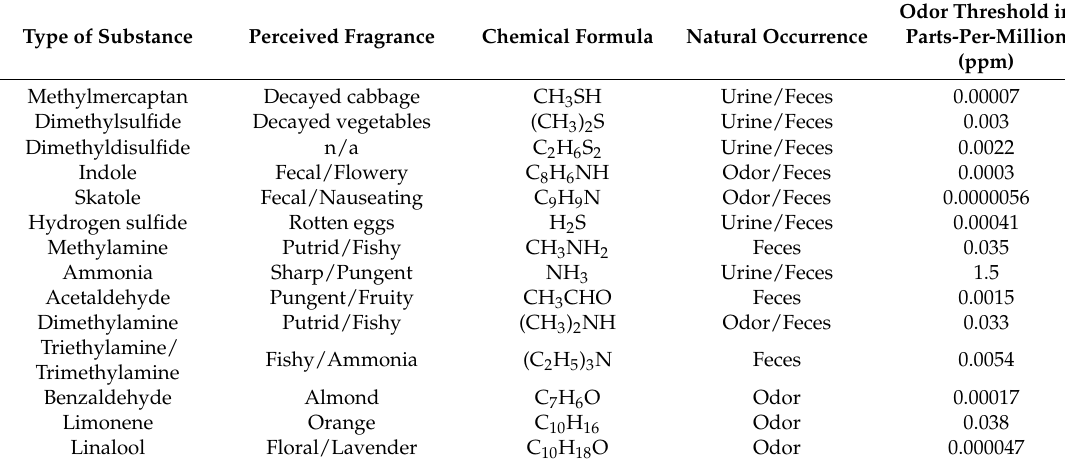
Table 1. Some of the most relevant odorous substances (odorants) occurring in human feces and urine and their odors [23–27]. The odor threshold values are taken from [28], except for benzaldehyde [29] and linalool